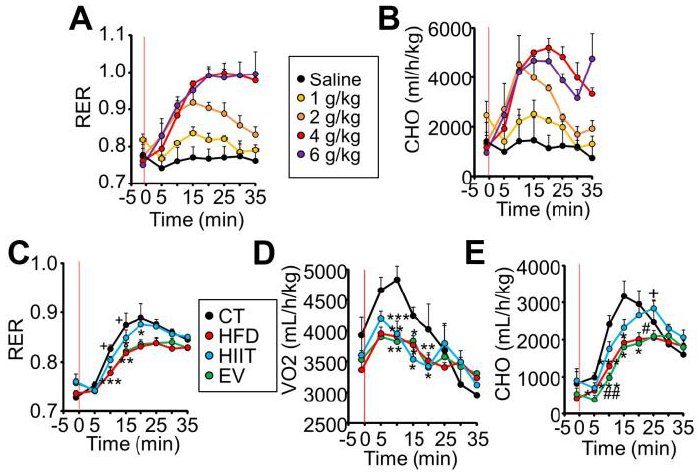
Figure 3. HIIT and EV-miRNAs improve glucose tolerance through different mechanisms: ( A , B ) Oral administration of glucose to CT lean mice increased their respiratory exchange ratio ( A ) and carbohydrate oxidation ( B ) in a dose-dependent manner, as measured by calorimetry. ( C ) Untreated HFD mice showed lower RER than CT mice in response to glucose administration, and this was normalized by HIIT but not EVs. ( D , E ) Obese mice showed lower O 2 consumption ( D ) and a partial improvement in carbohydrate oxidation as a result of HIIT ( E ). The red line in the graph indicates the time of glucose administration. N = 2/group ( A , B ), n = 5/group ( C – E ); * p < 0.05, ** p < 0.01, *** p < 0.005 with respect to the CT group; + p < 0.05 with respect to the HFD group; # p < 0.05, ## p < 0.01 between the HIIT and EV